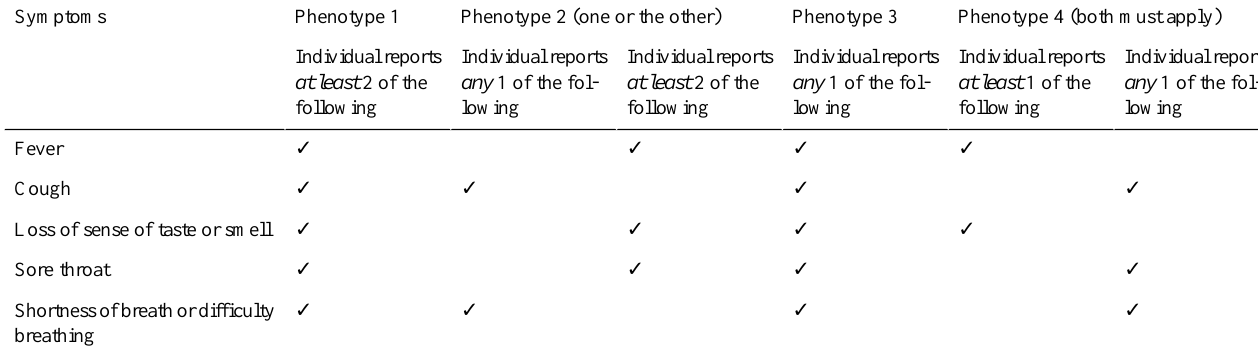
Table 1. Phenotypes for suspected COVID-19